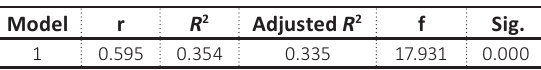
Table 14. Regressing intrapreneurship variable on employee enhancement